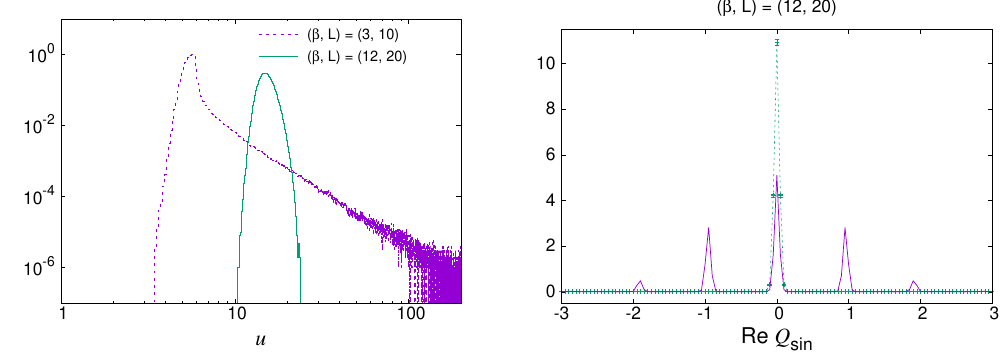
Figure 1 . The results obtained by the CLM for the non-punctured model using the sine de(cid:12)nition Q sin of the topological charge. (Left) The histogram of the magnitude u of the drift term de(cid:12)ned by (3.12) is shown for ( (cid:12); L ) = (3 ; 10) ; (12 ; 20) with (cid:18) = (cid:25) . (Right) The histogram of Re Q sin is shown for ( (cid:12); L ) = (12 ; 20) with (cid:18) = (cid:25) . The exact result obtained for ( (cid:12); L ) = (12 ; 20) with (cid:18) = 0 is shown by the solid line for